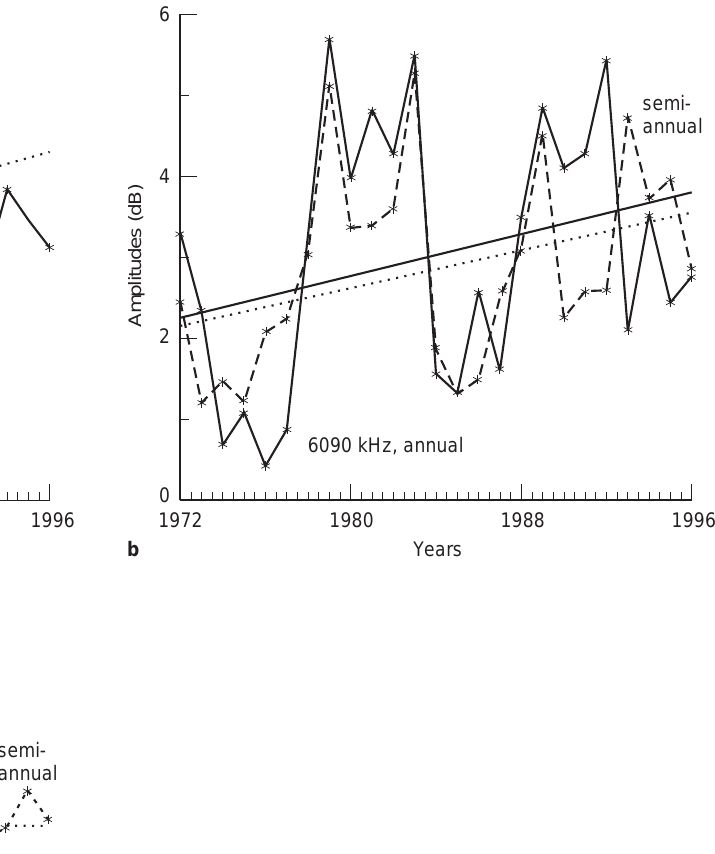
Fig. 2. a Trend in the yearly constant (slope = +0.177 dB/y) at 6090 kHz, 1972–1996. b Trends in the amplitudes of the AW ( Solid curve ; k = +0.063 dB/y) and SAW ( dashed curve ; k = +0.059 dB/y) in absorption at 6090 kHz, 1972–1996; k – slopes of curves. c Trends in the phases of the AW ( solid curve ; k = ) 1.622 day/y) and SAW ( bottom curve ; k = ) 0.105 dB/y) in absorption at 6090 kHz, 1972– 1996; k – slopes